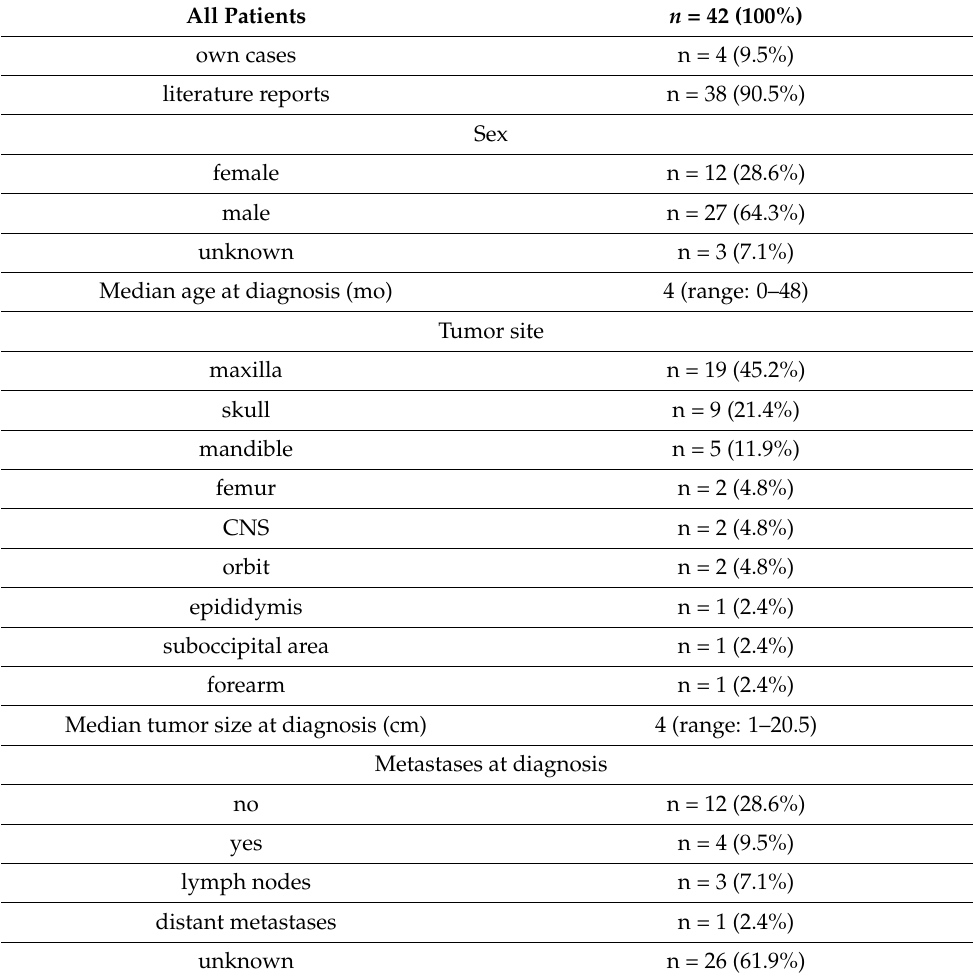
Table 5. Demographic and clinical data of the analyzed